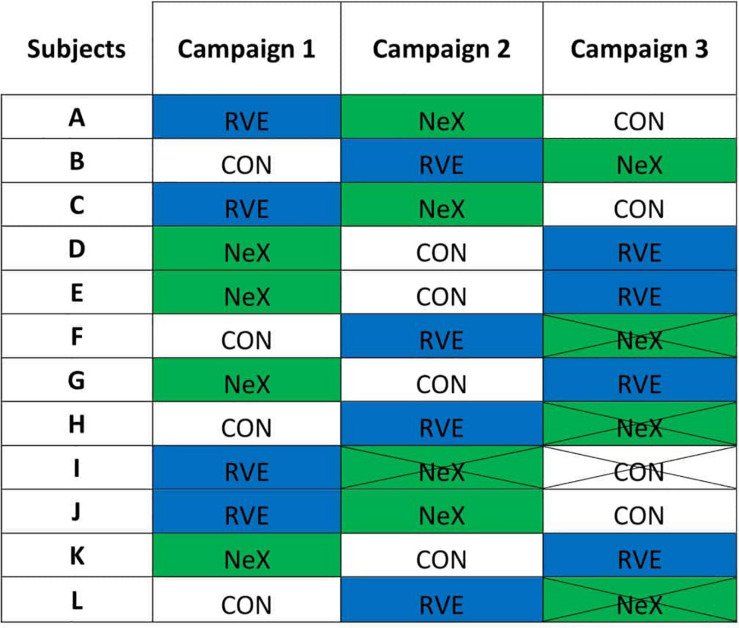
The different allocations of each subject. CON, control condition; RVE, Resistance vibration exercise condition; NeX, Resistance vibration exercise with nutritional supplementation. Campaign 2: I2 withdrawal on B-1. Campaign 3: F3 withdrawal on B-6, H3 withdrawal before the beginning of the campaign, L3 withdrawal on D-17 of HDBR.